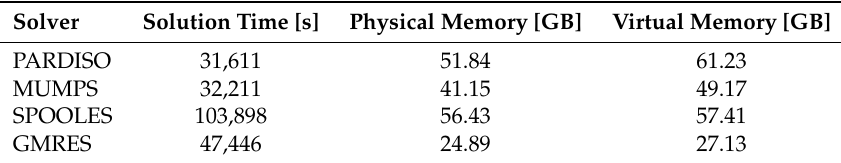
Table 3. Performance comparison of different